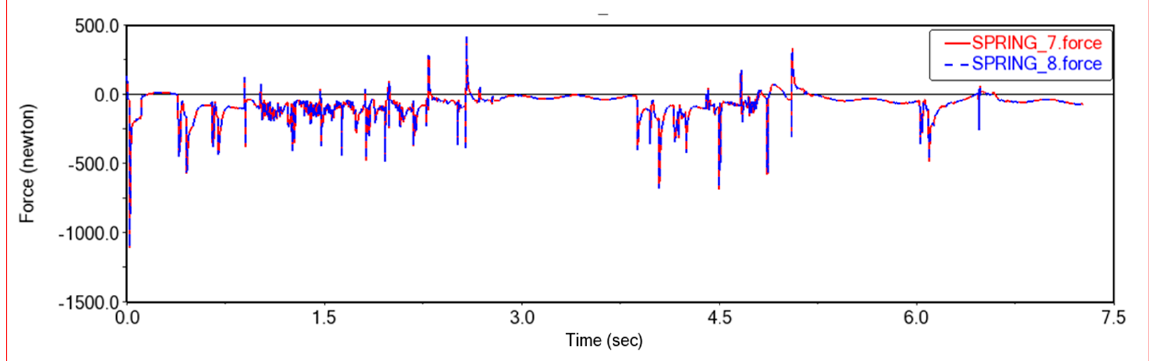
Figure 23. Force diagram of rear frame shock absorber. SPRING-7-Rear frame left shock absorber, SPRING-8-Rear frame right shock absorber.